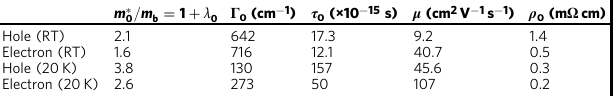
Table 1 DC mass enhancement factor ( m */ m b ), DC scattering rate Γ 0 = Γ ( ω → 0), static quasiparticle relaxation time ( τ 0 = ℏ (1 + λ 0 )/ Γ 0 ), mobility ( μ ), and resistivity ( ρ 0 ) of the conduction holes and electrons around 310 and 20